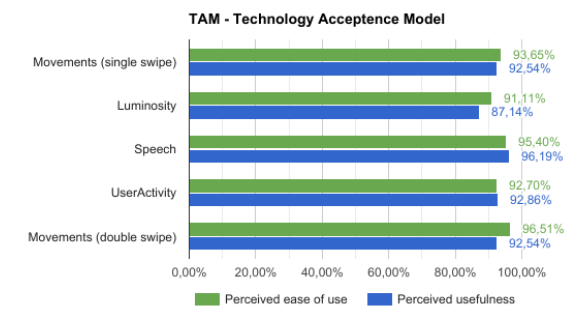
Fig. 14. TAM general acceptance degree.